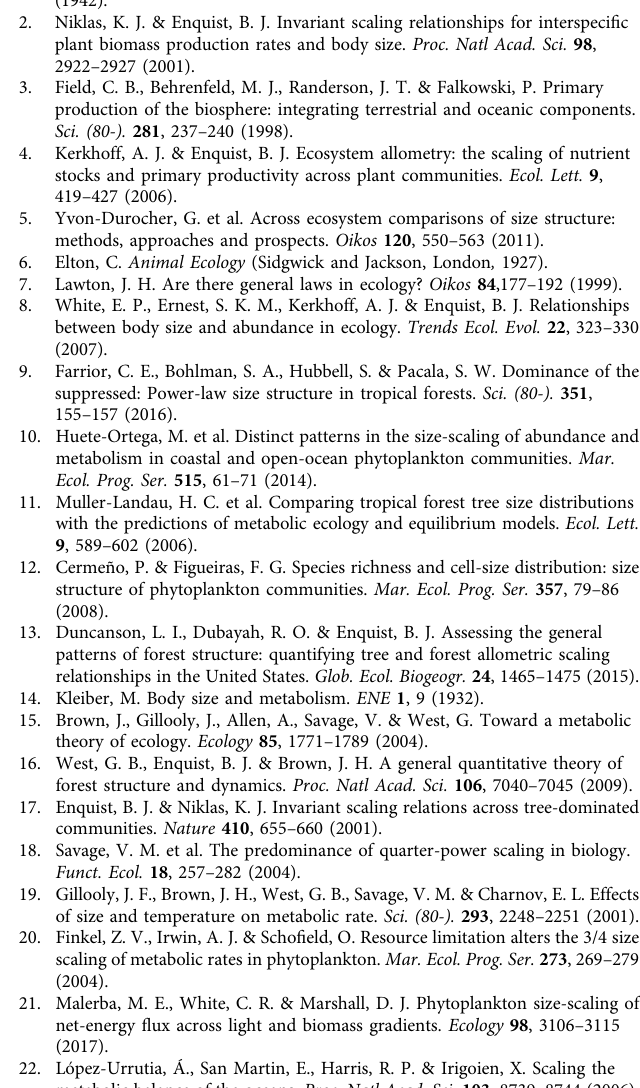
Figshare public repository (https:// fi gshare.com/s/013fba909417e89fe7e1). The data included in the deposit are speci fi cally intended for the replication of the